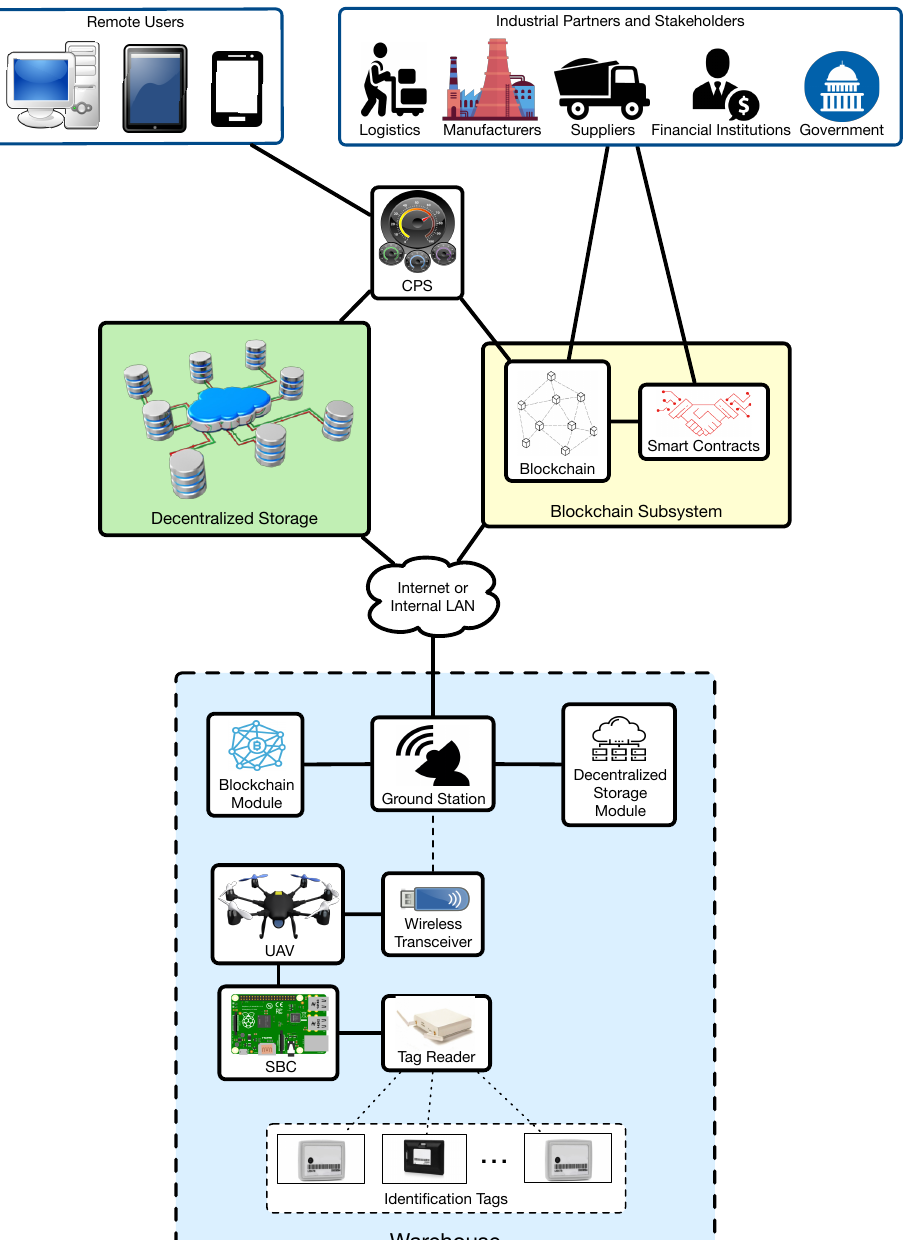
Figure 2. Proposed communications